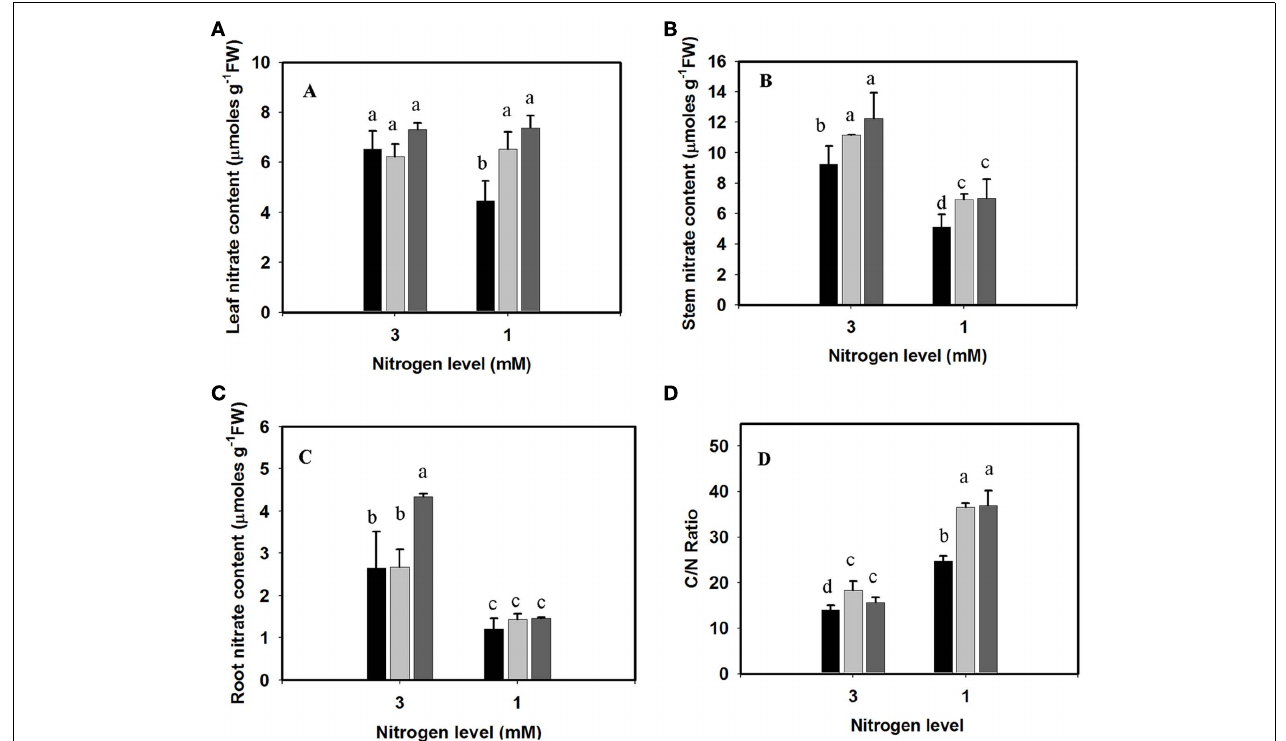
(D) C/N ratio calculated in the leaves of the three genotypes growing under same condition as in (A) . Data are means ± SD ( n = 3 each replicate represent four plants). Bars with different letters indicate a significant difference at P ≤ 0.05 (Tukey’s Honestly Significant